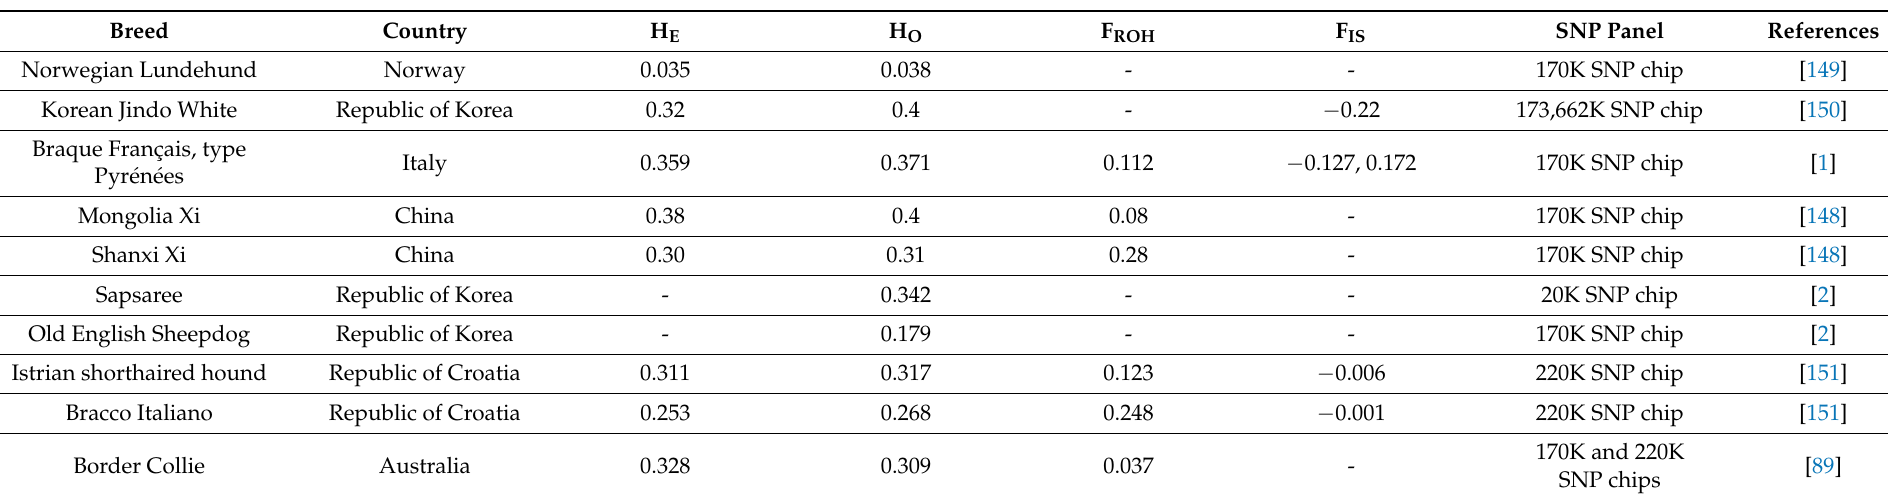
Table 4. Molecular genetic diversity on dog breeds using single nucleotide polymorphism markers.